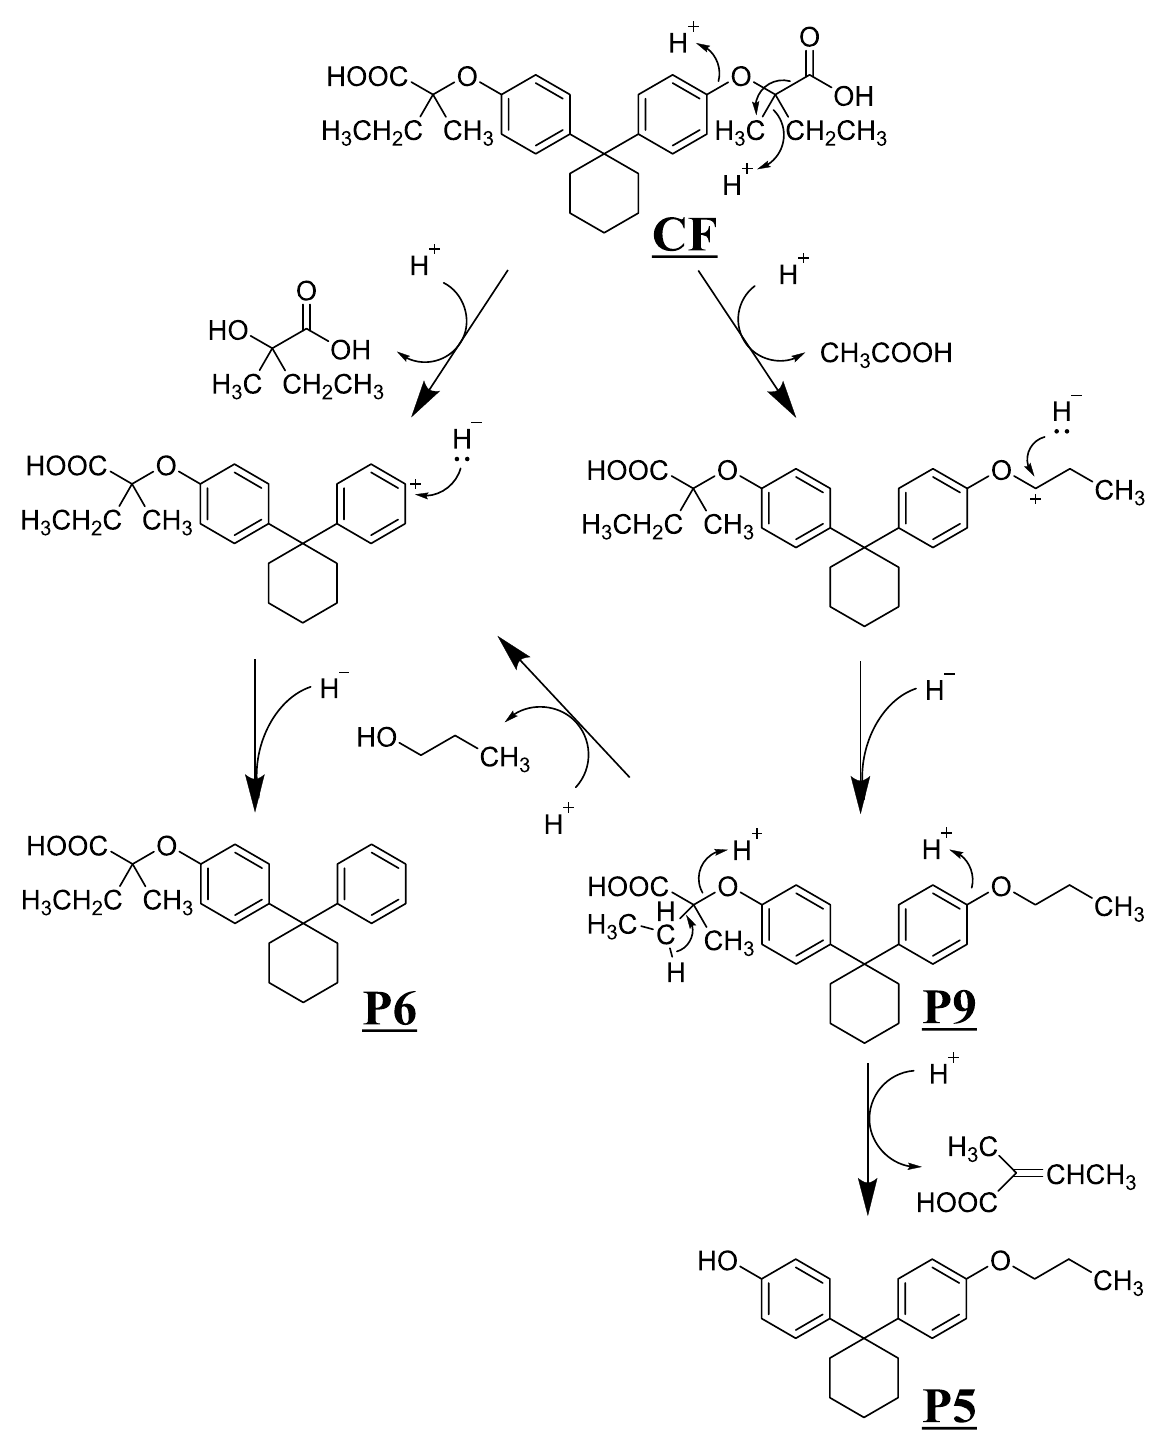
Fig. 5 Proposed photodegradation pathways for P5, P6 and P9 from